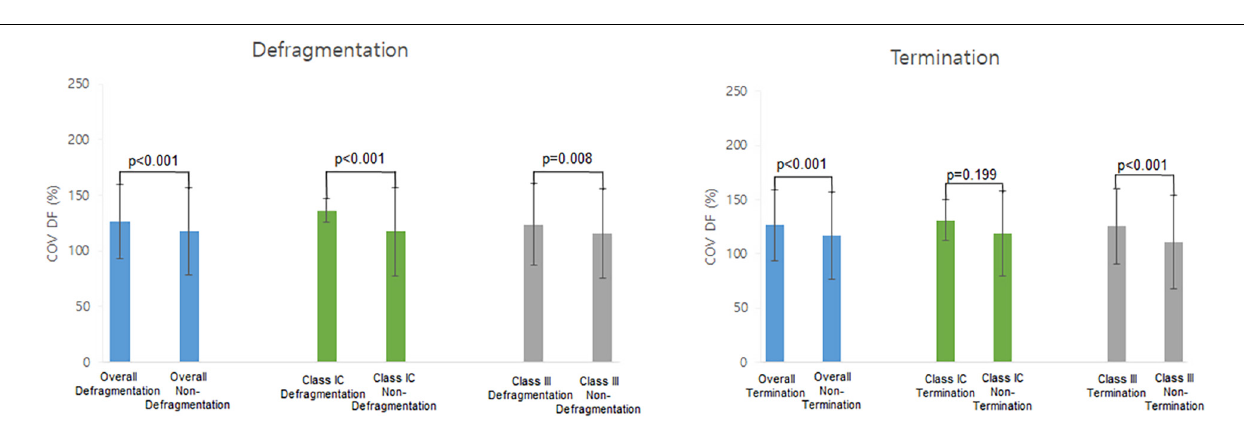
FIGURE 5 | Heterogeneity of dominant frequency (DF). Heterogeneity of DF was observed in overall defragmentation as well as termination